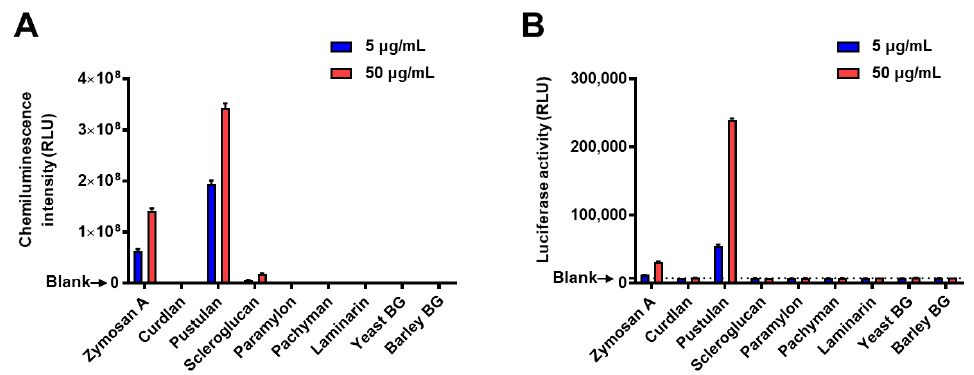
Figure 2. Sandwich ELISA-like assays specific for β-1,6-branched β-1,3- D -glucan using HRP or reconstituted NanoLuc as an indicator. Various glucans (5 or 50 μg/mL) bound to supBGRP-LgBiT immobilized on a microplate were detected using ( A ) biotin-labeled Neg1-E321Q/streptavidin HRP with a chemiluminescence substrate or ( B ) Neg1-E321Q-SmBiT with a luciferase substrate. Data are presented as the mean ± SD of values in duplicates, and are representative results from at least two independent experiments.